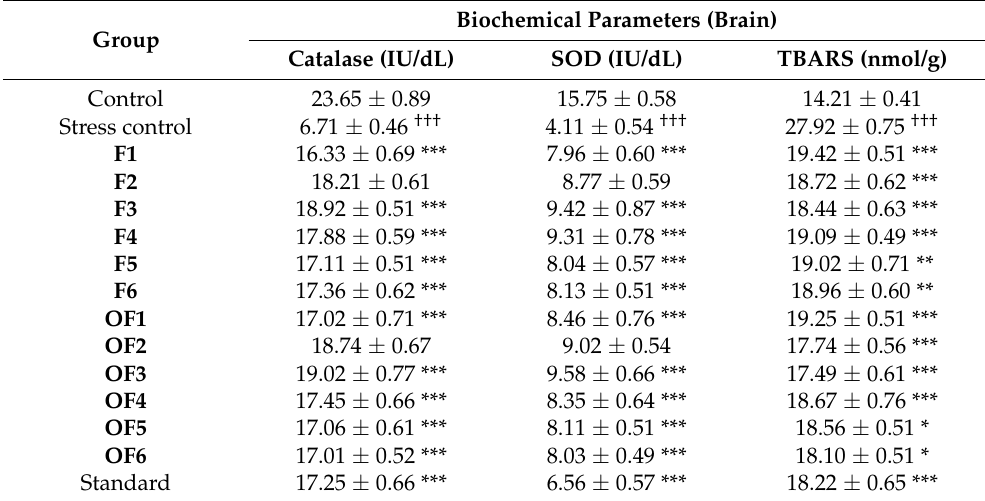
Table 5. Effect of flavonoids on different biochemical parameters in brain after restraint